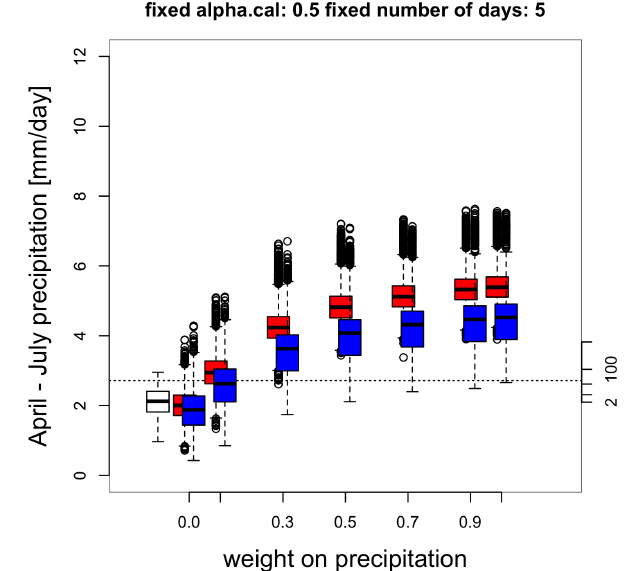
Figure A5. Distribution of April–July daily precipitation in obser- vations (white) and in simulations computed by the static (blue) and dynamic (red) generators as a function of α . The axis on the right indicates the probability of occurrence, assuming a normal distri- bution of daily precipitation with parameters estimated from white boxplot. The horizontal dotted line corresponds to the observed daily precipitation in April–July 2016. The boxes of boxplots in- dicate the median ( q 50), lower ( q 25), and upper ( q 75) quartiles. The upper whiskers indicate min[max( T ), 1 . 5 × ( q 75 − q 25)]. The lower whisker has a symmetrical formulation. The points are the simulated values that are above or below the defined whiskers.